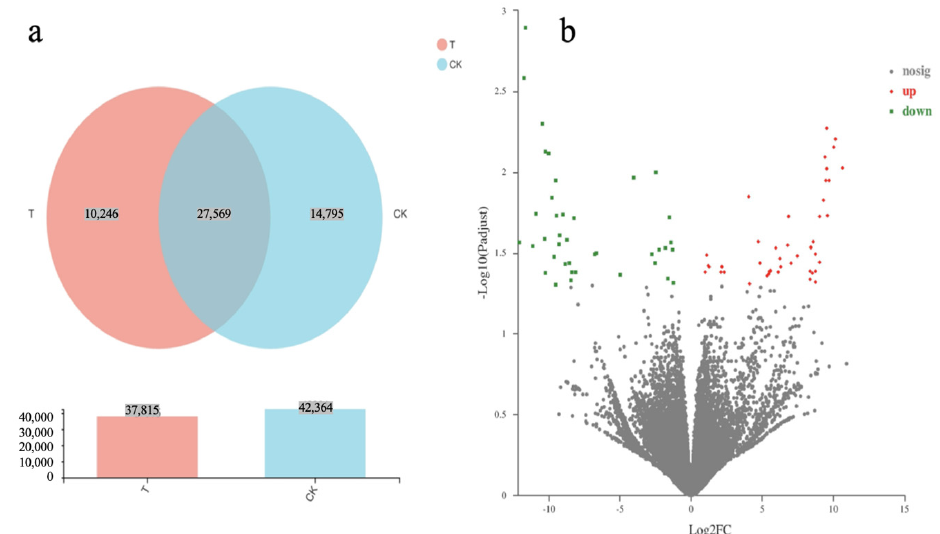
Figure 5. The differential gene analysis expression of T9 on D. denneanum. ( a ) Venn diagram. ( b ) Volcano plot. The q -value < 0.05 and |log 2 (fold change)| > 1 was used as the screening condition for differential expression.